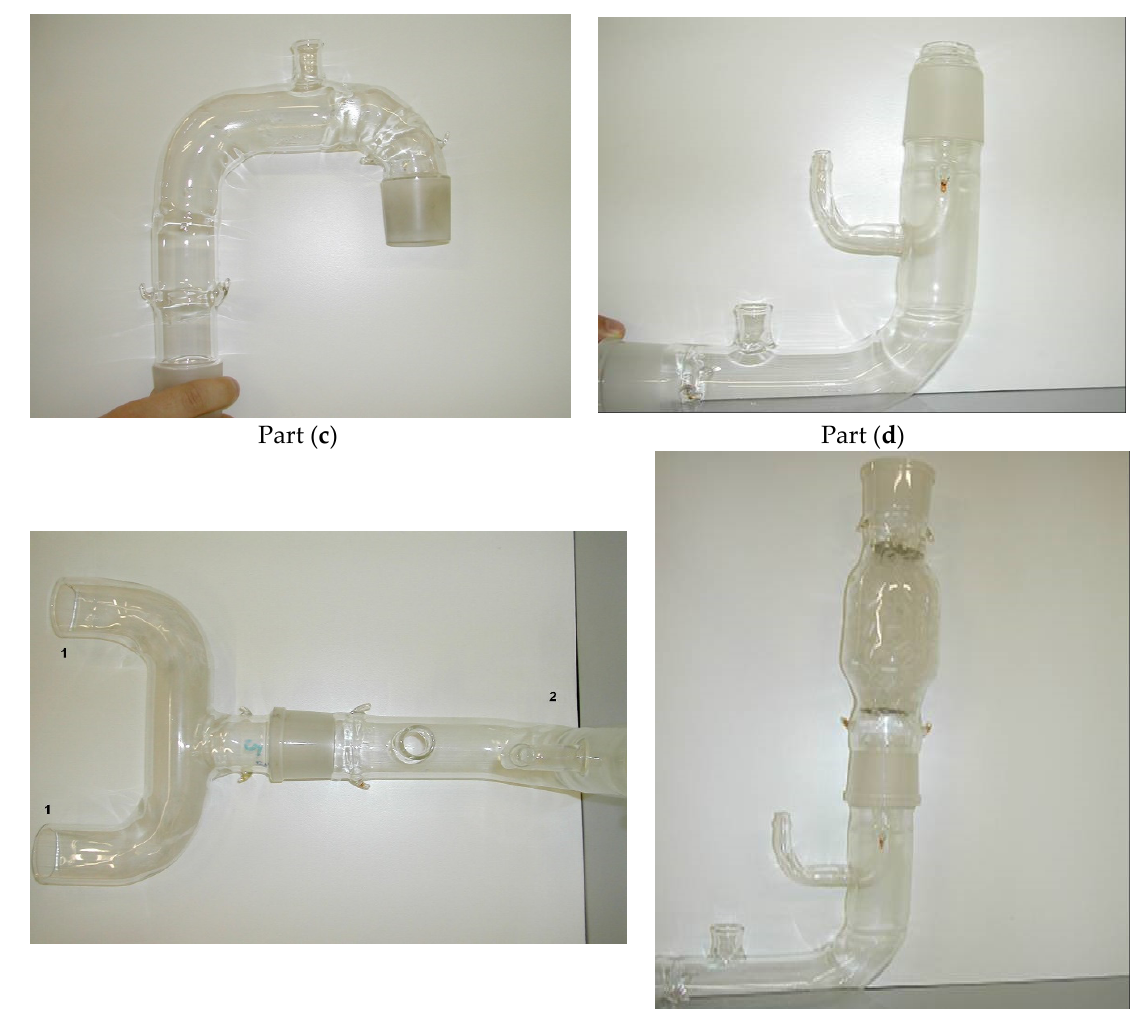
Figure 2. Main parts of the mini-MODUS glass components: ( a ) entrance / exit mouth, ( b ) oxygenation reactor filled with Rashig rings, ( c ) degassing chamber, and ( d )